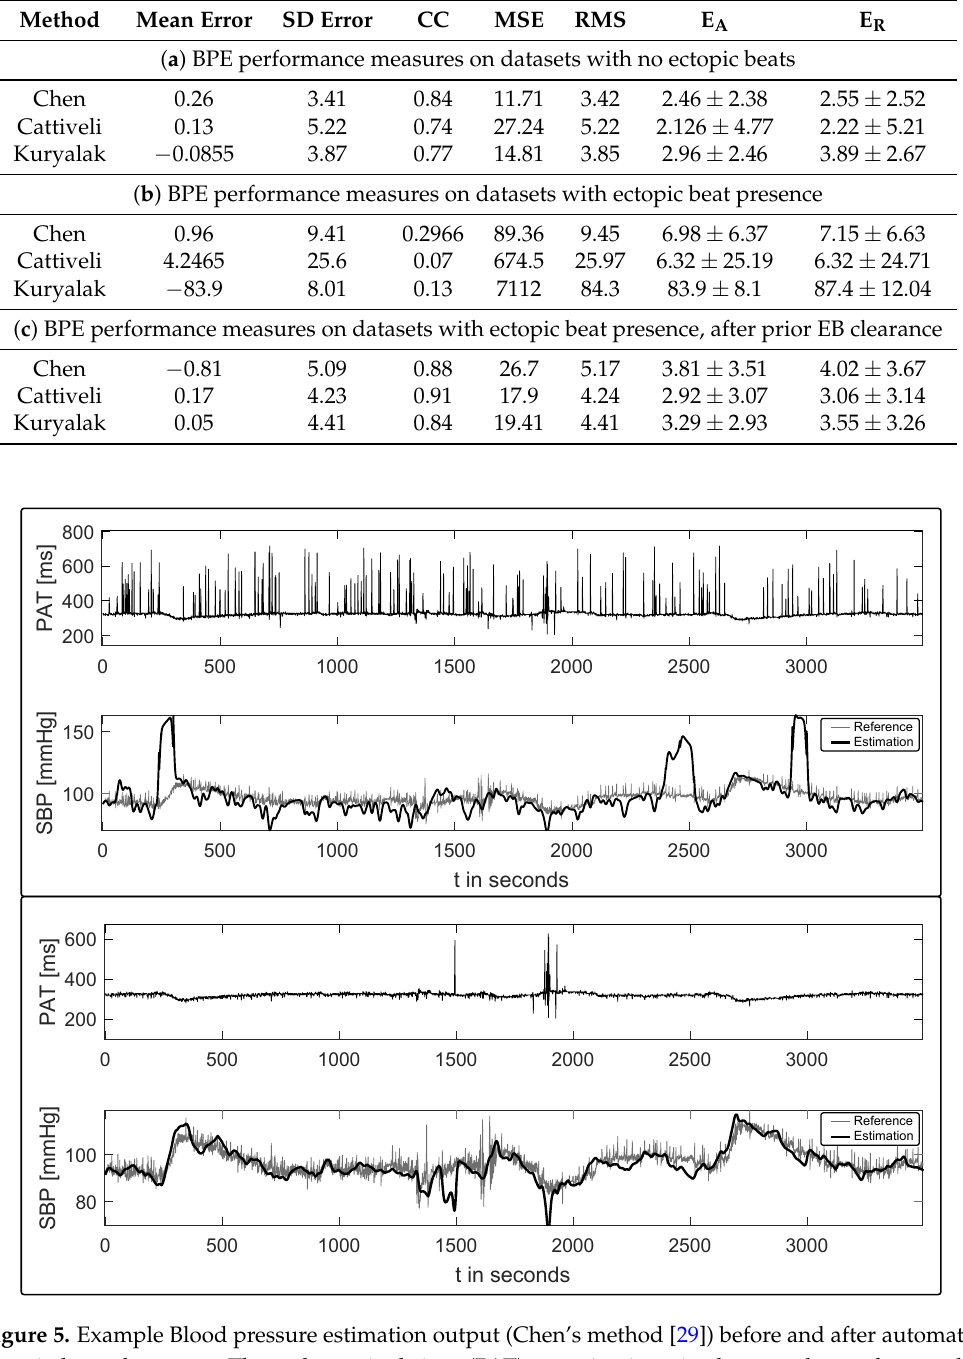
Figure 5. Example Blood pressure estimation output (Chen’s method [29]) before and after automatic ectopic beat clearance. The pulse arrival time (PAT) trace is given in the top plots, whereas the continuous systolic blood pressure (SBP) reference along with the estimated SBP (bold) are plotted at the